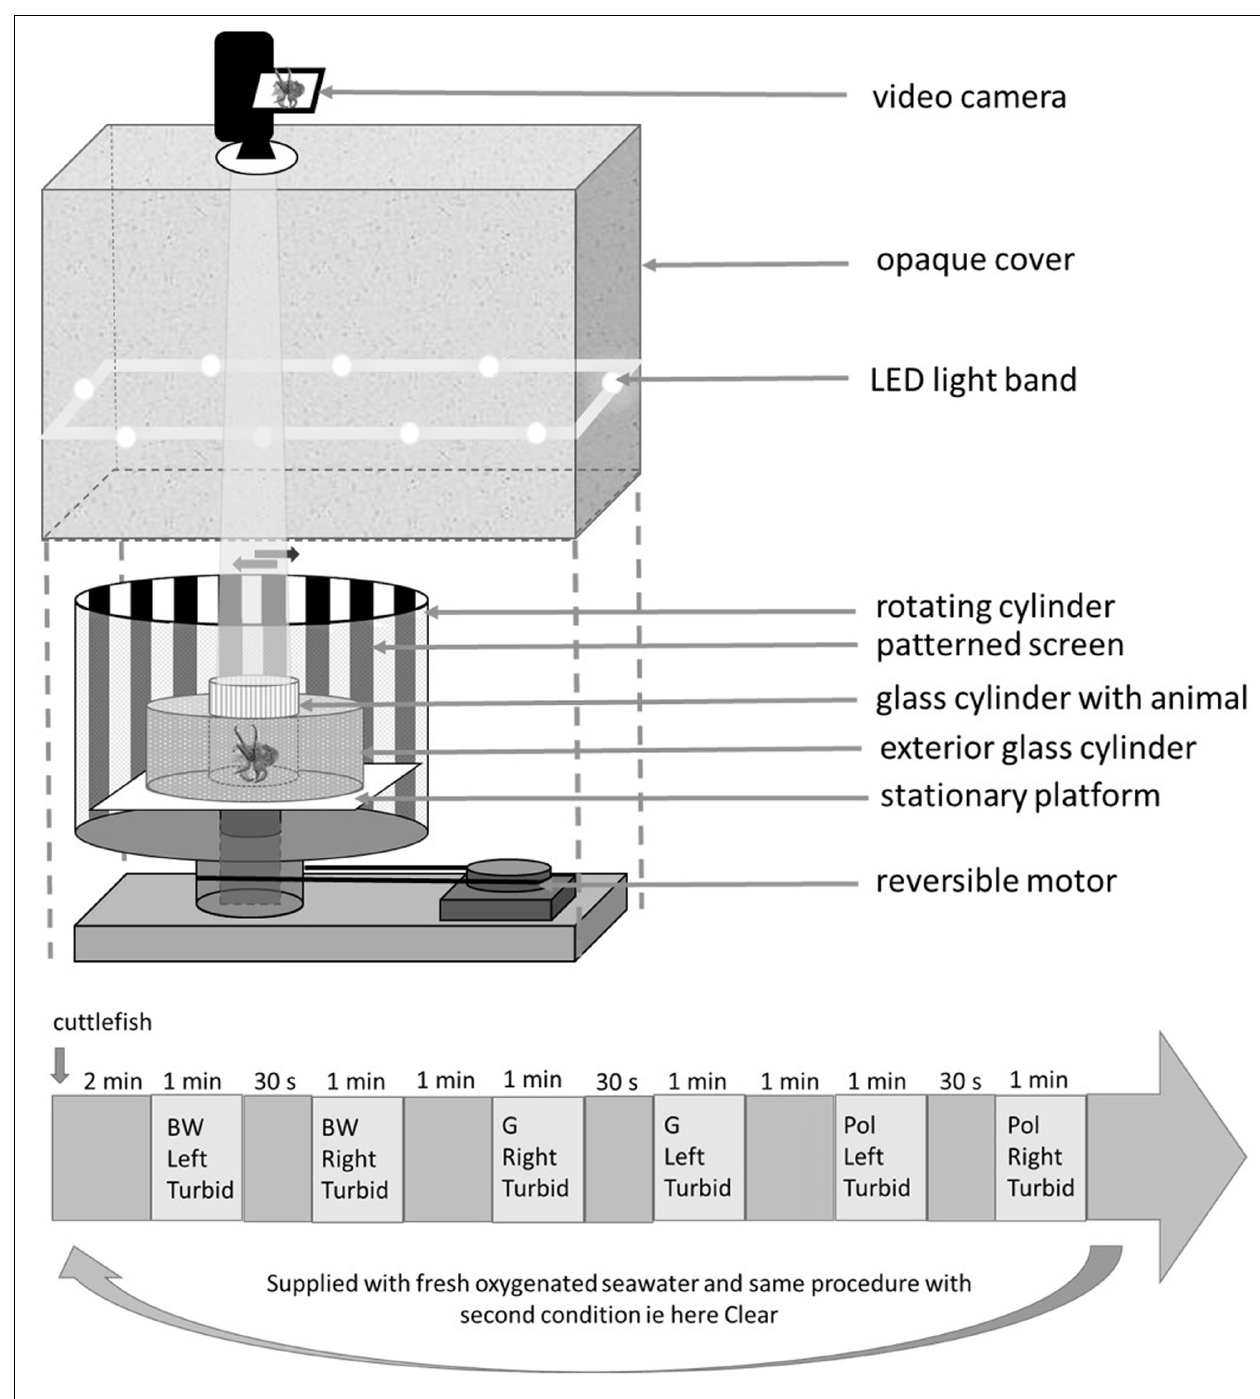
FIGURE 1 | Optomotor apparatus and an example of a procedure for which the order was randomized. The apparatus consisted of a cylinder showing three patterns (BW, black and white; G, gray; Pol, polarized stripes.) and rotated by a reversible motor placed on the inner wall of the apparatus. Two glass cylinders, one holding the animal and the other with more or less turbid water, were placed on a stationary platform in the center of the apparatus. In the procedure, the external cylinder was supplied with turbid seawater (condition 1) and for condition 2 the same experiment was done with clear seawater. Between the two conditions the cylinder holding the animal was supplied with fresh oxygenated